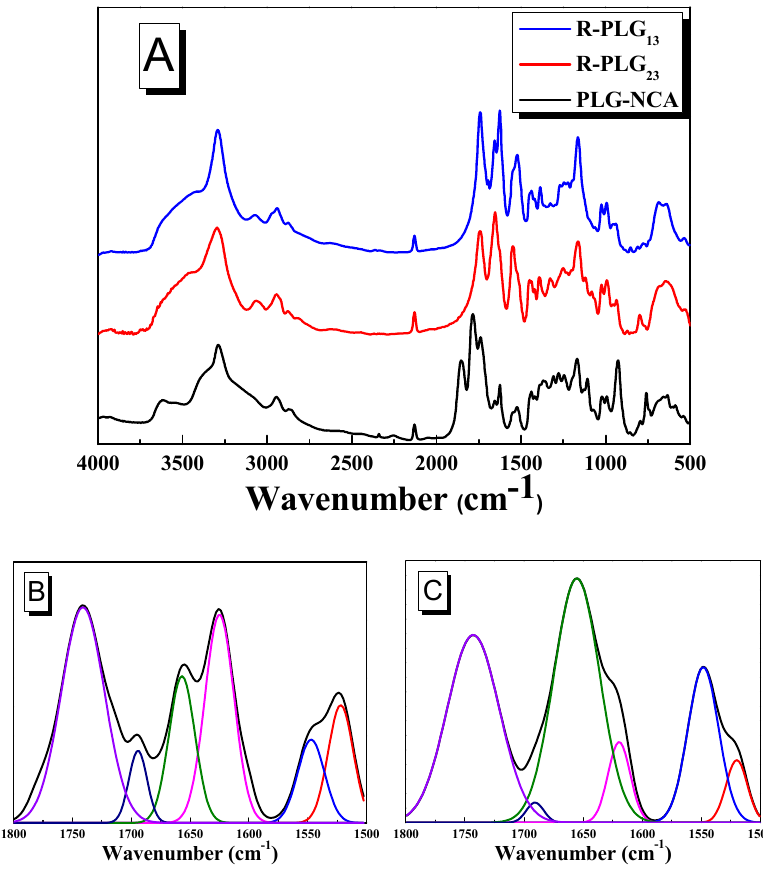
Figure 4. Solid FTIIR spectra of: ( A ) R-C, R–PLG 13 and R–PLG 23 ; and the de-convoluted amide I absorption peaks of: ( B ) R–PLG 13 ; and ( C ) R–PLG 23. Table 1. Molecular weight of R–PLG 13 and R–PLG 23 evaluated from 1 H NMR and Maldi-Tof mass spectra and fractions of secondary structure determined from FTIR and CD